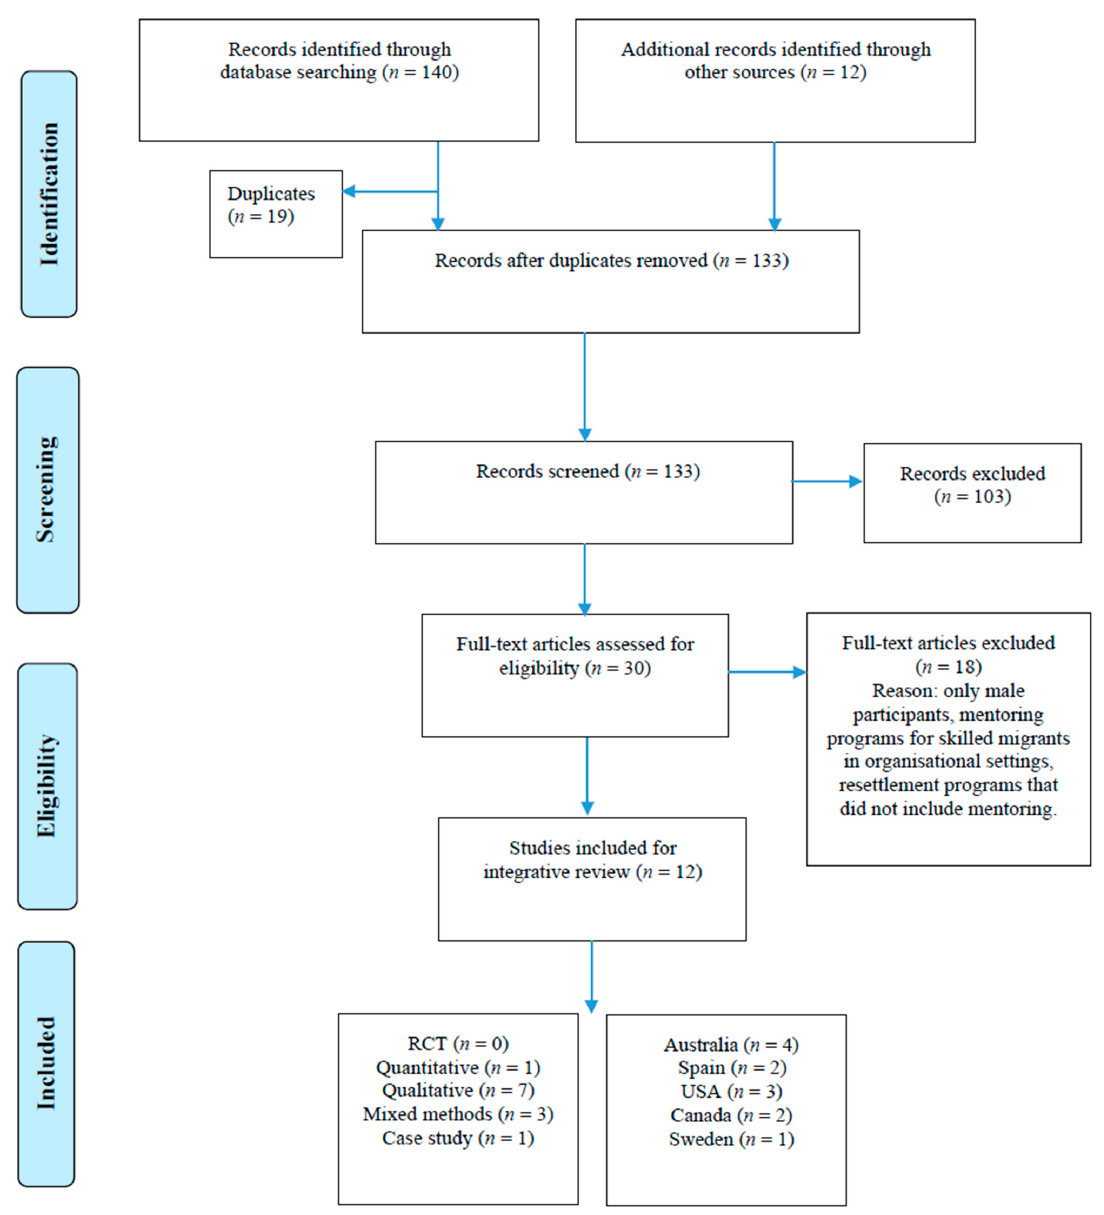
Figure 1. Literature selection process using PRISMA framework.